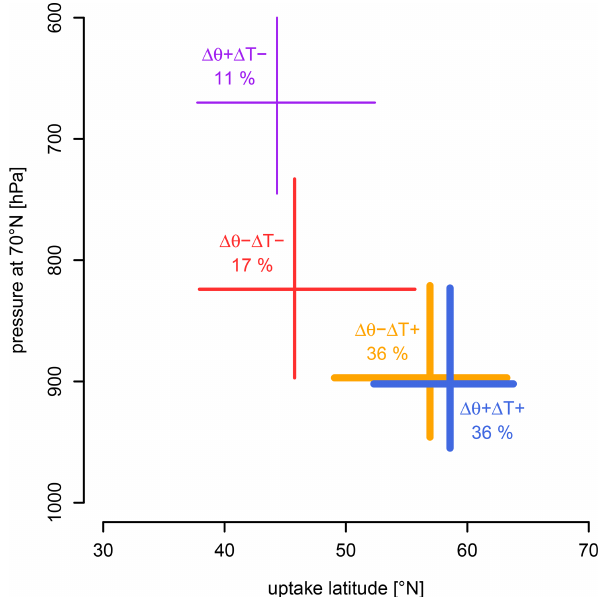
Figure 11. Summary figure showing for moist-air intrusions in the North Atlantic the interquartile range of moisture uptake latitude vs. pressure at 70 ◦ N for the four trajectory categories. Line thickness is proportional to the relative contribution to the moisture transport, also indicated in percent